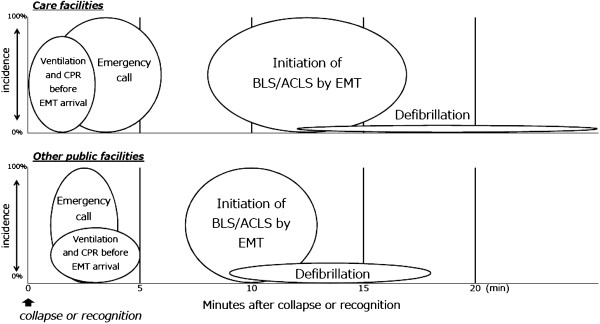
Placements of links in the "chain of survival" for care facilities and other facilities. The widths of circles represent an interquartile range (25-75%). The heights of circles denote the incidence. CPR cardiopulmonary resuscitation, EMT emergency medical technician, BLS basic life support, ACLS advanced cardiovascular life support.